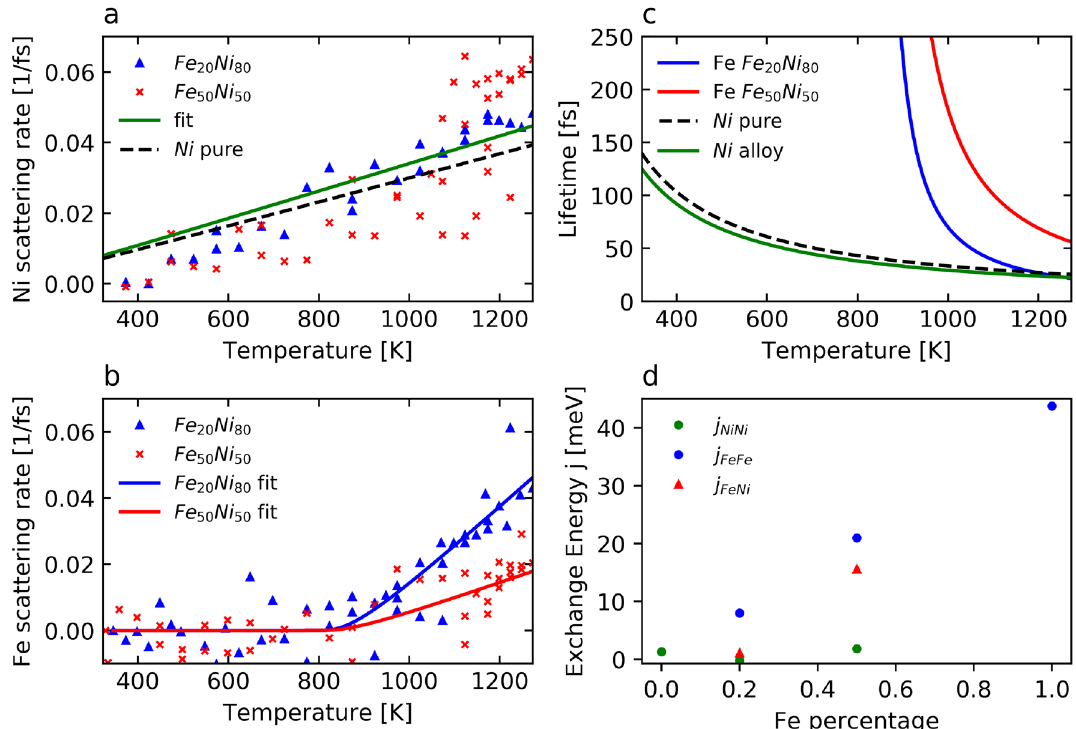
Figure 3. Scattering rates and exchange interaction energies. ( a ) and ( b ) Inelastic scattering rate in the different stoichiometries for nickel ( a ) and iron ( b ). The dashed line in ( a ) shows the rate for pure nickel 23 . The green line is the fit for both alloy stoichiometries. For clarity, the error bars are shown in the Supplementary Information only 32 . ( c ) Corresponding scattering lifetimes. ( d ) Intralattice exchange energy vs. the iron content. Values for the pure nickel and the Fe 20 Ni 80 are adapted from ref. 35 . Values for pure Fe 50 Ni 50 and pure iron are adapted from 16